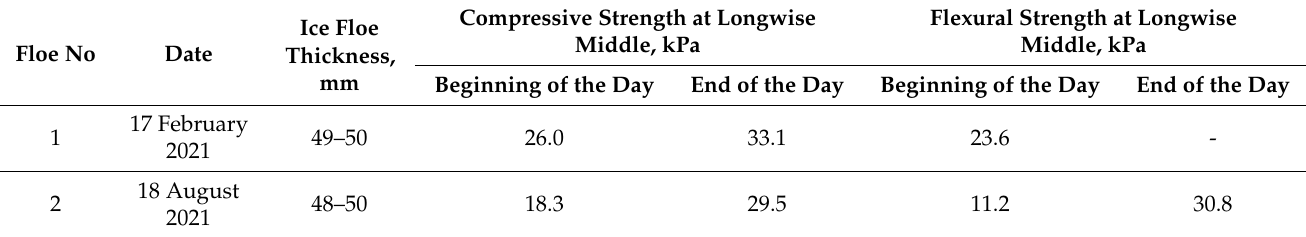
Table 1. Characteristics of ice fields used for the